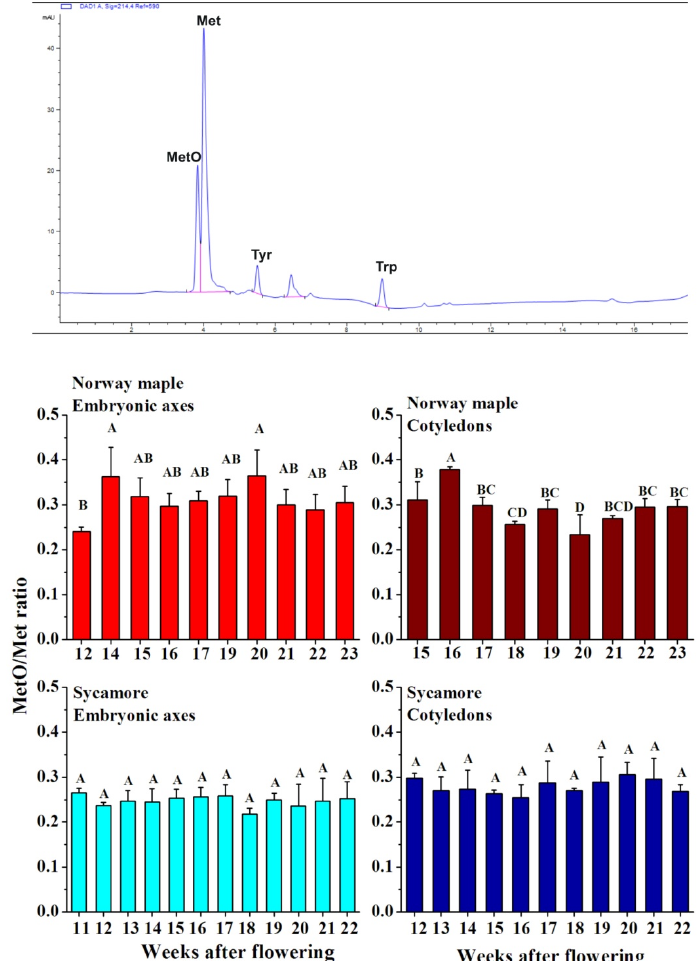
Figure 2. Detection of methionine (Met) oxidized to methionine sulfoxide (MetO) in proteins of